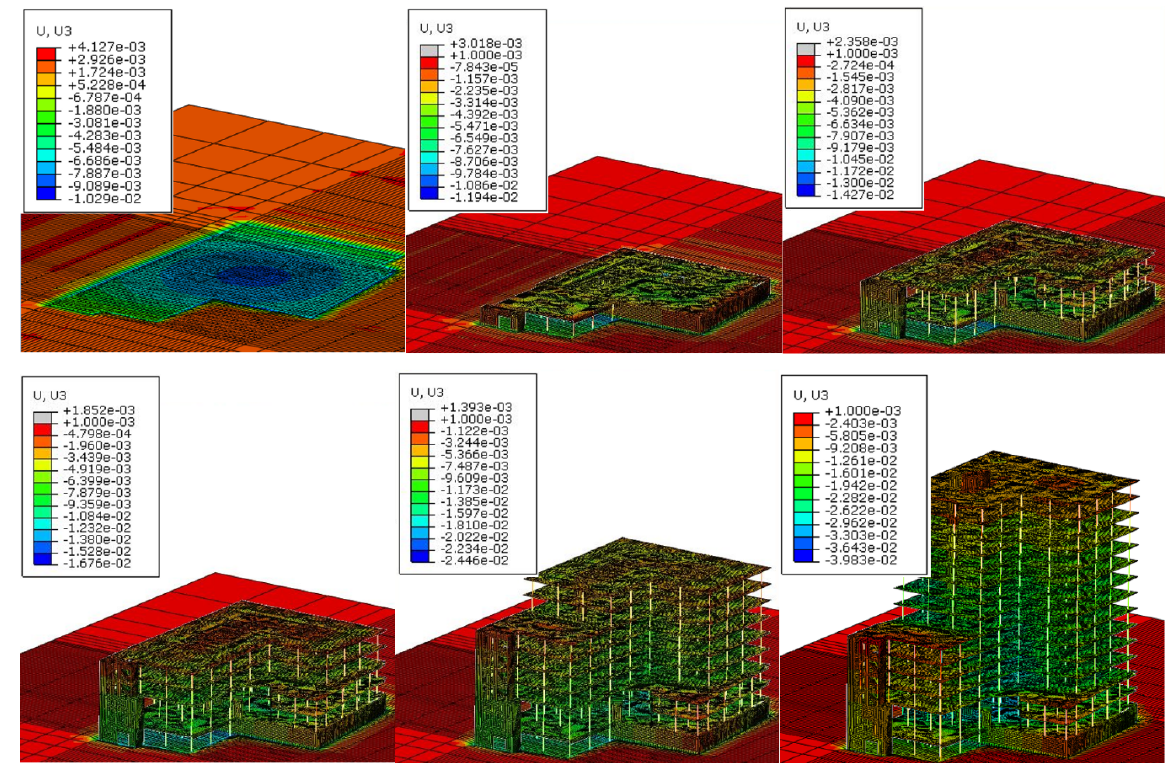
Figure 5: Vertical displacements [m] in selected successive phases of construction